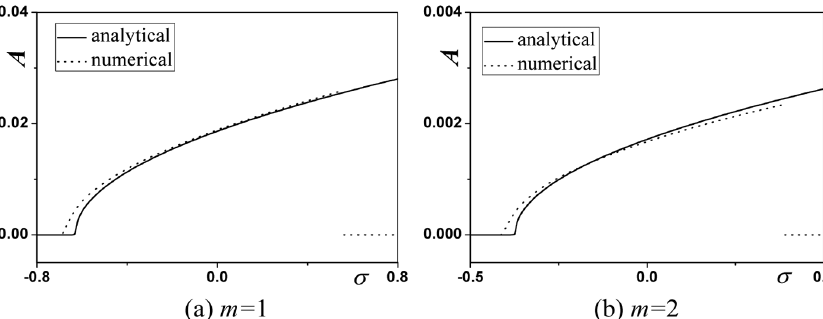
Fig. 15. Comparison of analytical and numerical results: Eq. (10).